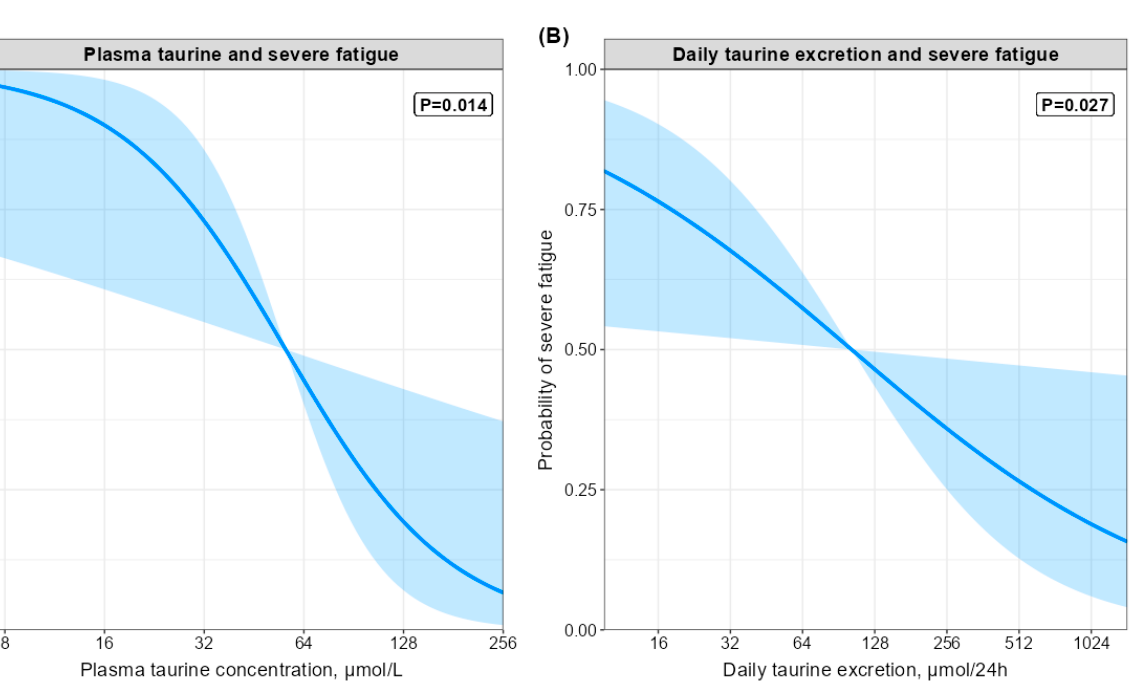
Table 6. Logistic regression analyses of daily amino acid losses and protein intake with severe fa- tigue.